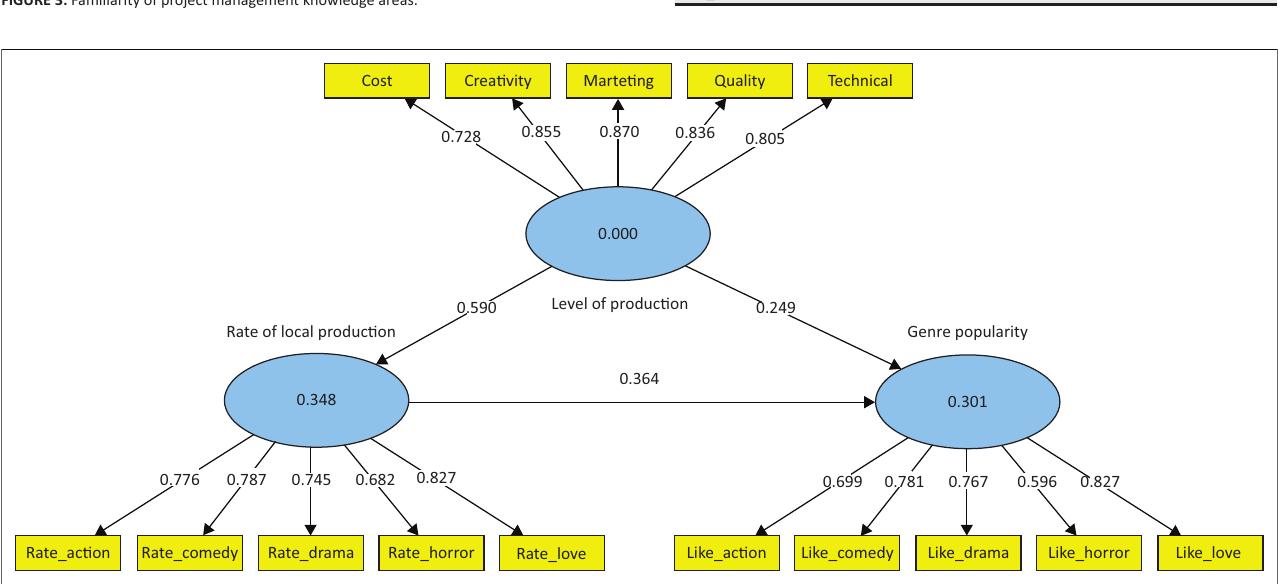
FIGURE 4: Partial least squares path modelling estimation among levels of local motion picture production, rate of local motion picture production and film genre popularity.